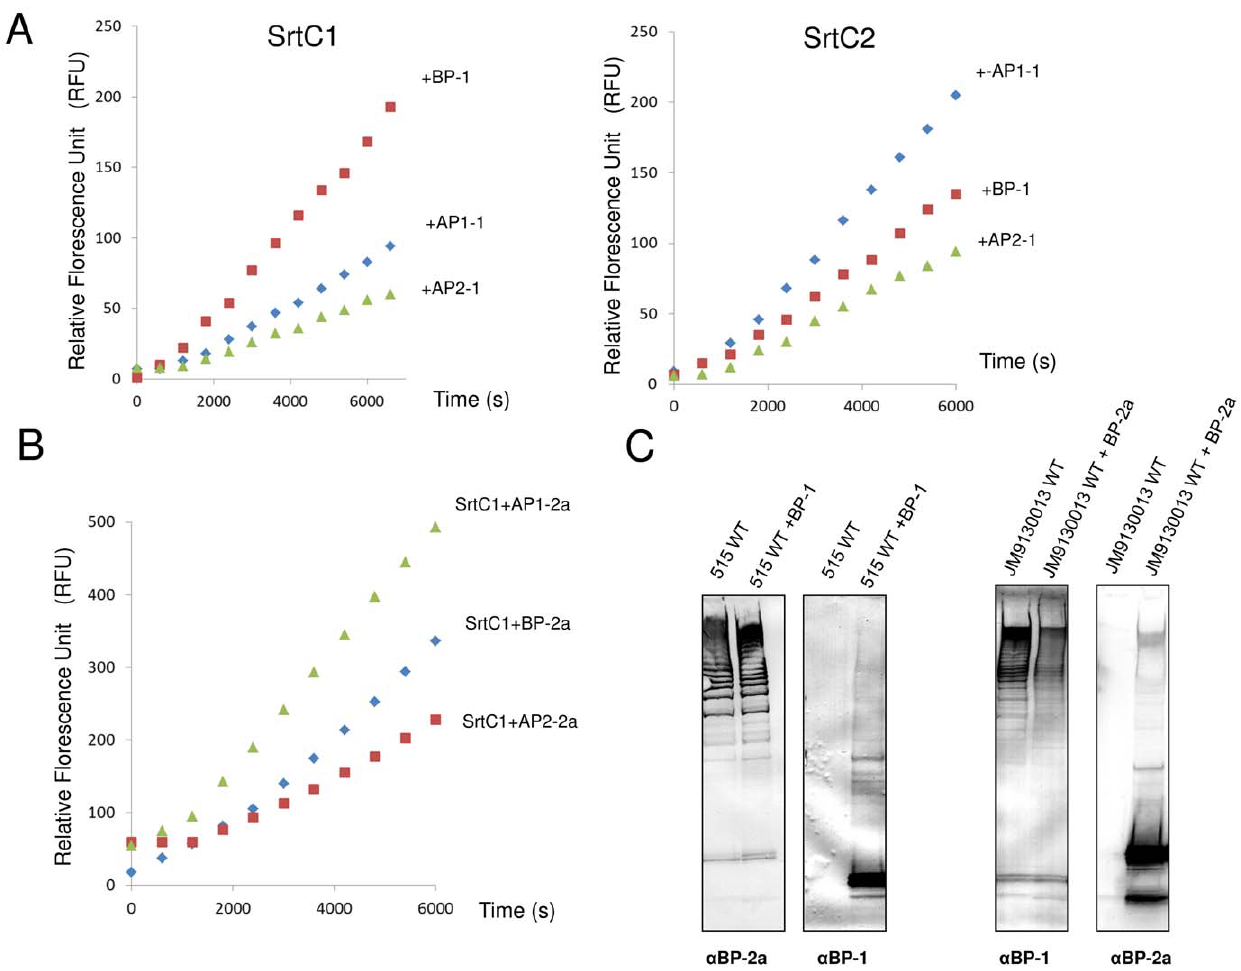
Figure 4. FRET assay with PI-1 and PI-2a peptides for substrate specificity analysis of PI-1 SrtC1 and SrtC2. (A) The reaction solutions contained 128 m M of PI-1 fluorescent peptides and 25 m M of SrtC1-TM (left panel) or SrtC2-TM (right panel). The reactions were performed at 37 u C in the assay buffer containing 25 mM HEPES pH 7.5, 100 mM NaCl and 1 mM DTT. Fluorescence emission was monitored every 10 minutes and an increase in fluorescence intensity was observed in the presence of BP, AP1 and AP2 peptides mimicking the LPXTG motif of PI-1 pilus proteins. (B) Reactions were performed with PI-2a peptides and 25 m M of SrtC1-TM in the same conditions described above. (C) In vivo substrate specificity analysis. Immunoblots of total protein extracts from GBS 515 (containing SrtC1 and SrtC2 of pilus island 2a) and JM9130013 (containing SrtC1 and SrtC2 of pilus islands 1 and 2b) wild-type and complemented strains with plasmids expressing the backbone proteins of PI-1 (BP-1) and PI-2a (BP-2a), respectively. The nitrocellulose membranes were probed with antisera specific for BP-1 and BP-2a.